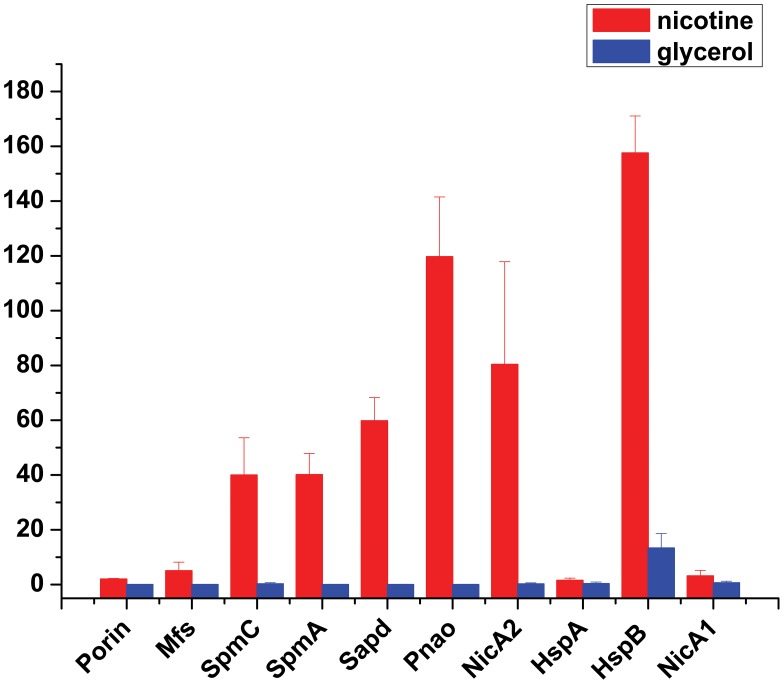
Expression level changes of proteins that were involved in nicotine degradation.The expressions of proteins Porin, Mfs, SpmC, SpmA, Sapd, Pnao, NicA2, HspA, HspB, and NicA1 were identified and detected by MS-based spectral counting. The plot shows expression level of various proteins in different media: red, nicotine medium; blue, glycerol medium. Bars indicate the average ± s.e.m of the normalized spectral counts (y axis).